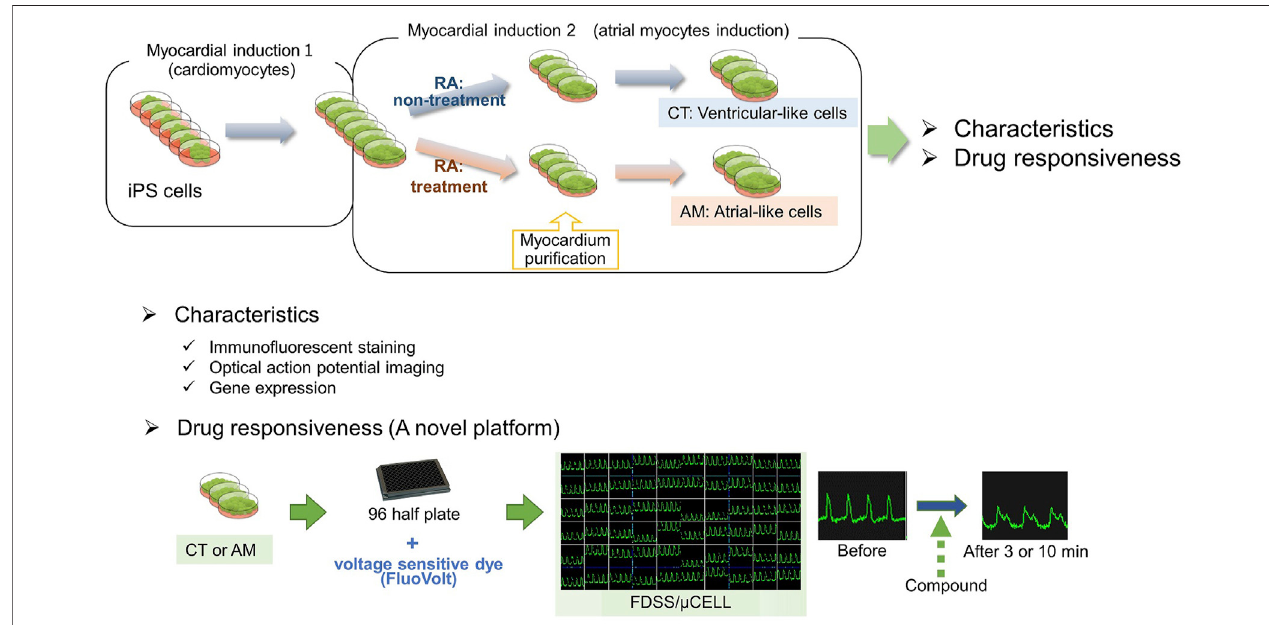
FIGURE 7 | Graphic abstract. In the present study, we generated a hiPS-derived atrial-like phenotype by supplemented RA during the cardiac mesoderm induction. Thereafter, we examined the acute response to several drug administration in the hiPS-CMs with (atrial-like subtype) or without (ventricular-like subtype) treatment of RA by using a high-throughput drug evaluation system, which might be a valuable platform to detect potential risks for drug-induced atrial arrhythmias.